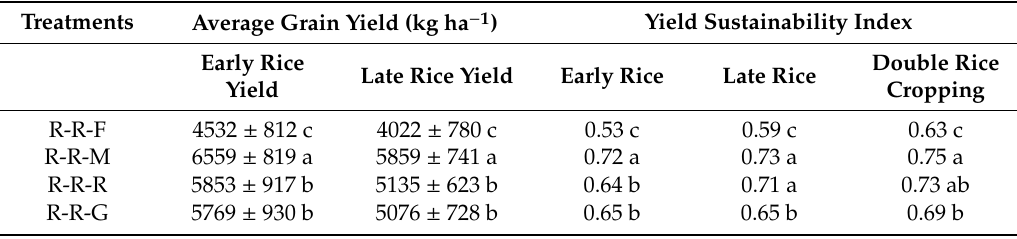
Table 1. E ff ect of long-term green manure rotations on the sustainability yield index (SYI) of double-rice cropping systems in acidic paddy